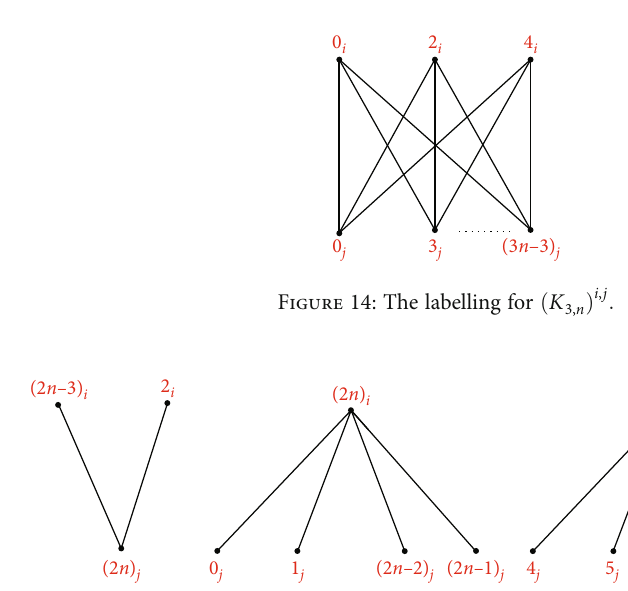
Figure 15: The labelling for ð K